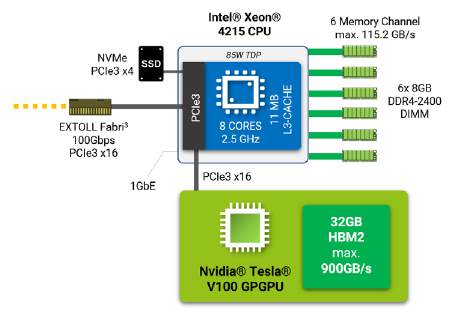
Figure 2: DEEP-EST Prototype ESB